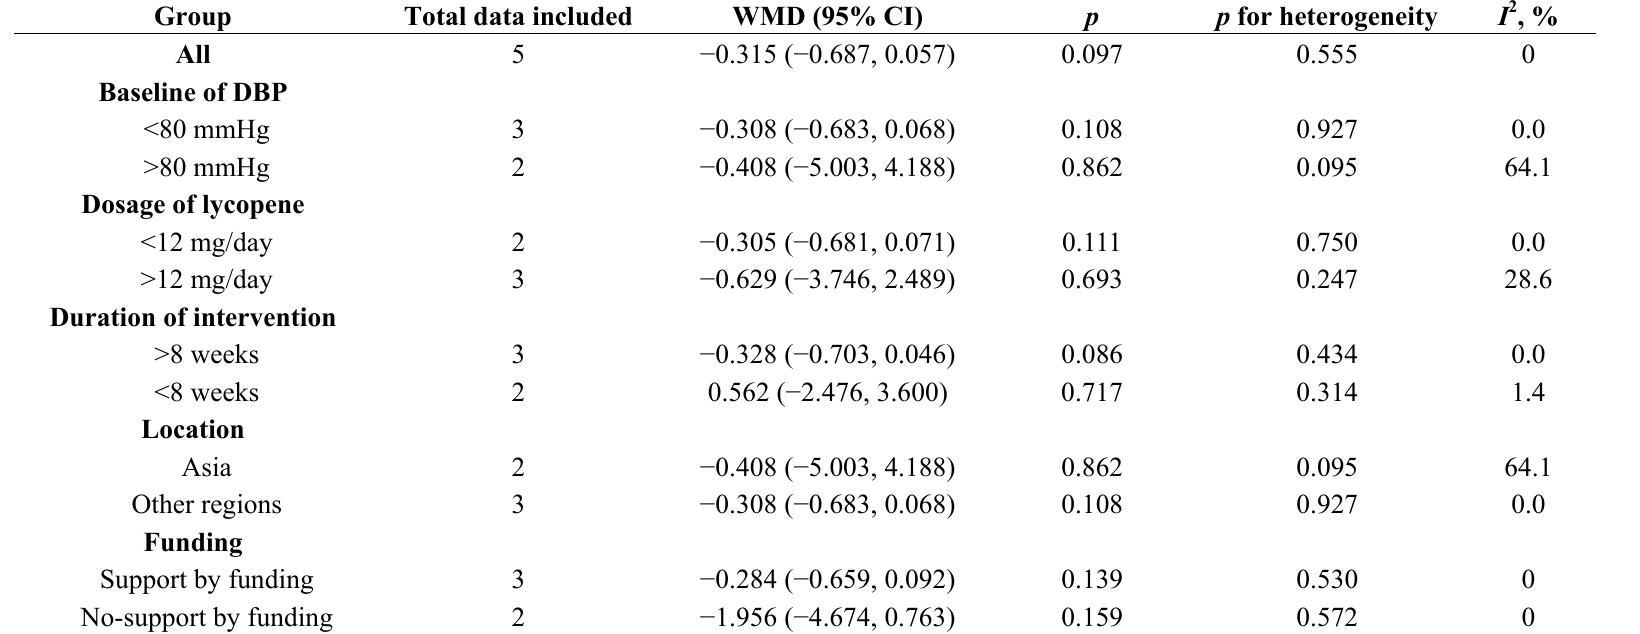
Table 4. Results of stratified analyses of the blood pressure, B: Diastolic blood pressure. Group Total data